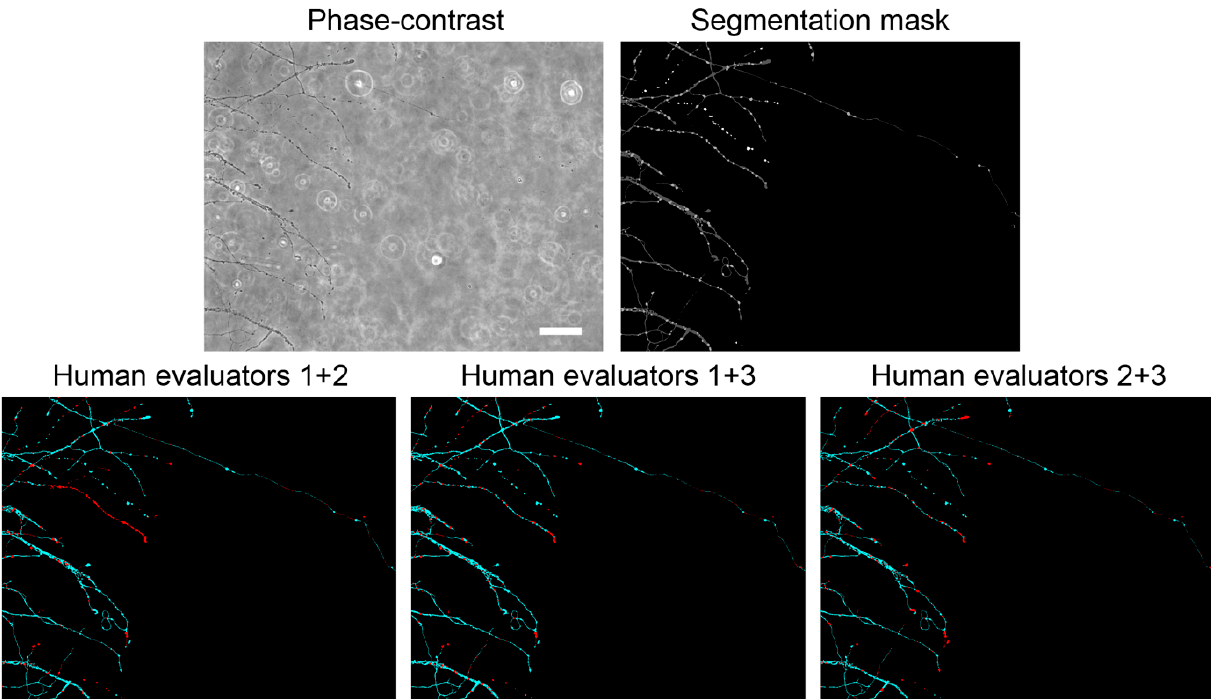
Figure 3. Performance of the EntireAxon CNN compared to human evaluators. Phase-contrast validation image, its EntireAxon CNN segmentation mask, and the consensus labeling masks of two human evaluators that show the segmentation overlap (cyan) or difference (red) between the labels. Scale bar: 100 µm.